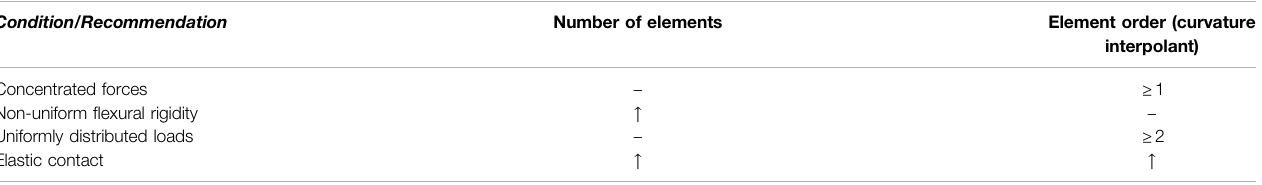
TABLE 3 | Summary of recommendations to increase either the number of elements or the order of interpolants based on model assumptions and robot-environment conditions.